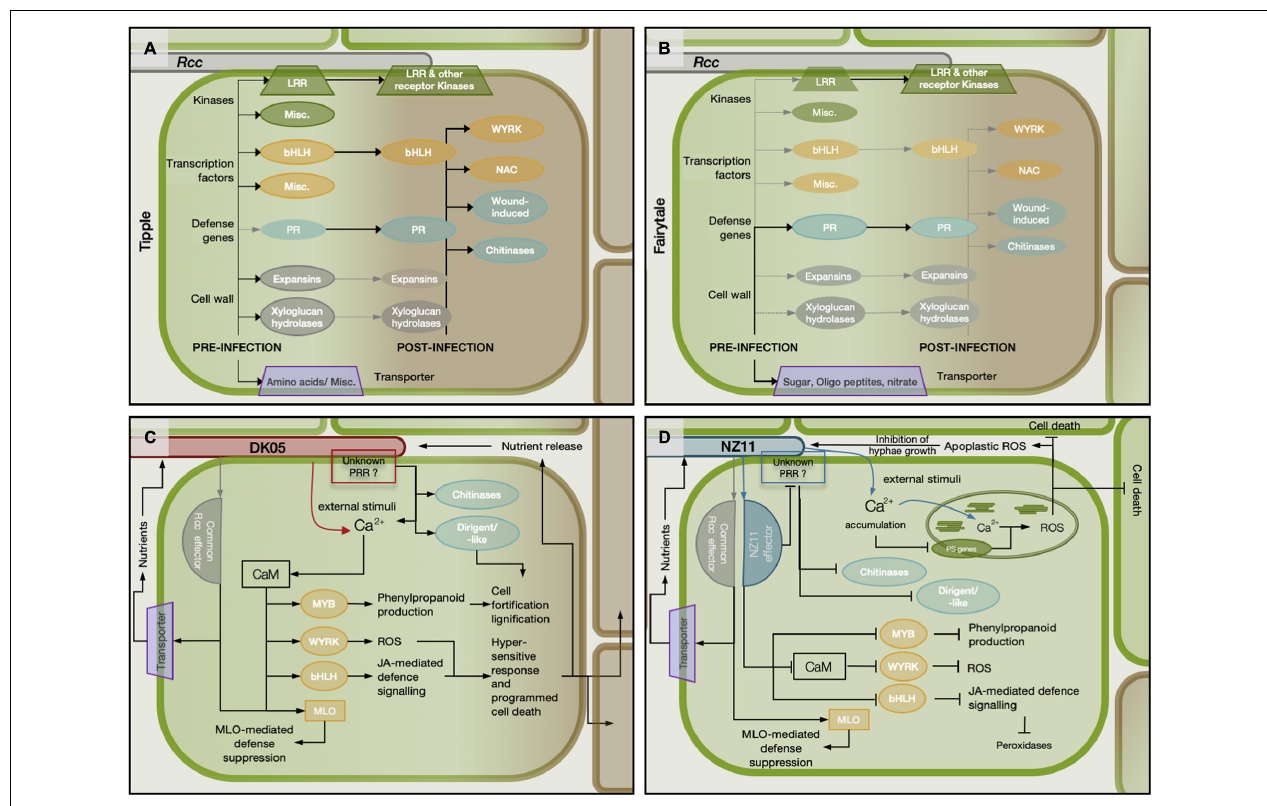
FIGURE 8 | Schematic representation of potential modulation of the barley ( Hordeum vulgare L ) regulatory network during the infection with two different isolates of Ramularia collo-cygni . (A,B) Depict the expression of specific groups of genes before and after infection in the barley cvs Tipple and Fairytale, respectively. The focus is on expression differences between the two barley cultivars. (C) Schematic representation with the more aggressive isolate DK05. (D) Modulation of the host network during infection with the mild Rcc isolate NZ11. Solid lines with arrowheads represents higher expression before infection in the respective cultivar and activation of gene expression by Rcc colonization. Solid lines with blunt ends depict down-regulation of gene expression. Dotted gray lines with arrowhead show genes that are not or very low expressed.